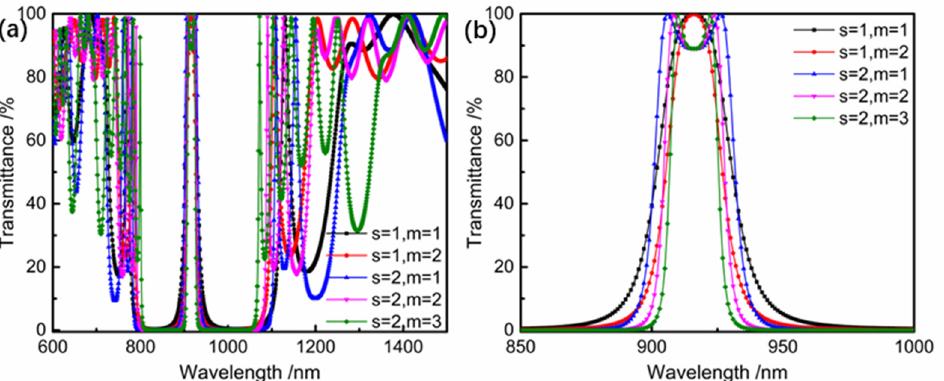
Figure 4. Transmittance spectral curve of the initial film system on the output surface ( a ) 600~1500nm, ( b ) 850~1000 nm. ( b ) 850~1000